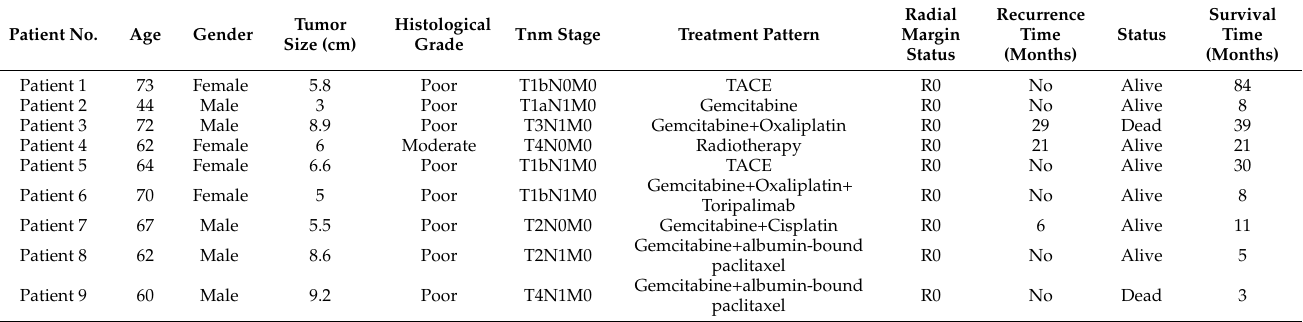
Table 2. Detailed characteristics of successfully downstaged patients by conversion therapy.